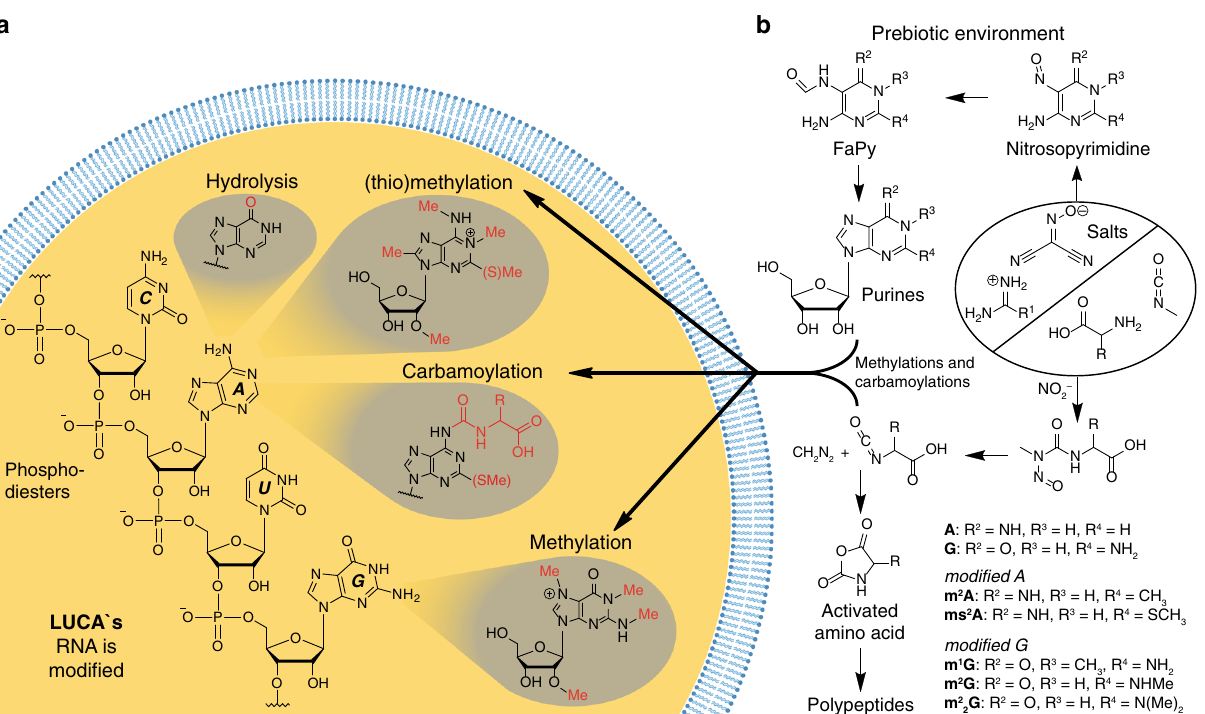
Fig. 1 LUCA ’ s modi fi ed bases. a The chemical structure of ribonucleic acid (RNA) and of some modi fi ed bases. Different (thio)methylation sites and amino acid purine modi fi cations in LUCA are marked in red. b Amidine salts are converted into nitrosopyrimidines, which then form formamidopyrimidines. Reaction with ribose provides a set of canonical and non-canonical nucleosides that are assumed to have been present in